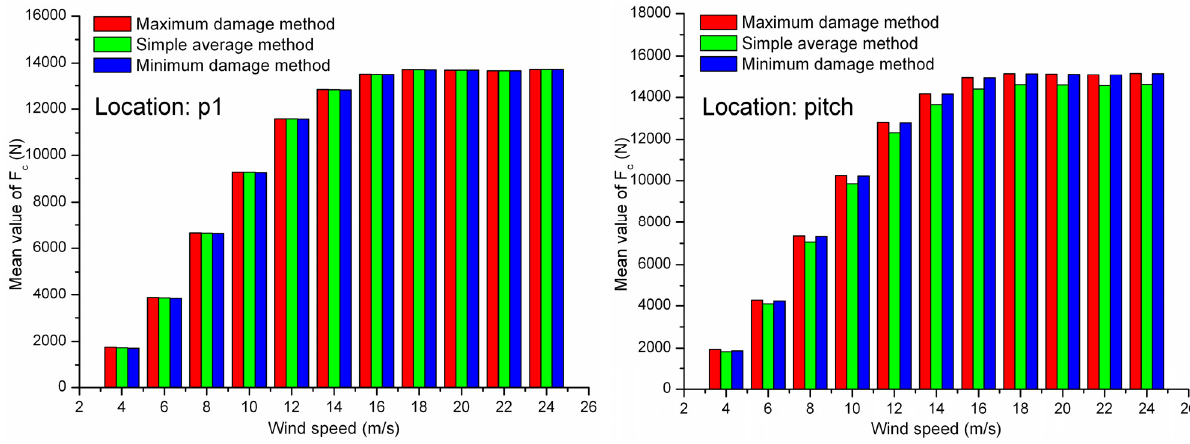
Figure 20. Comparison of mean contact forces when using different methods at different contact points and wind speeds (4P